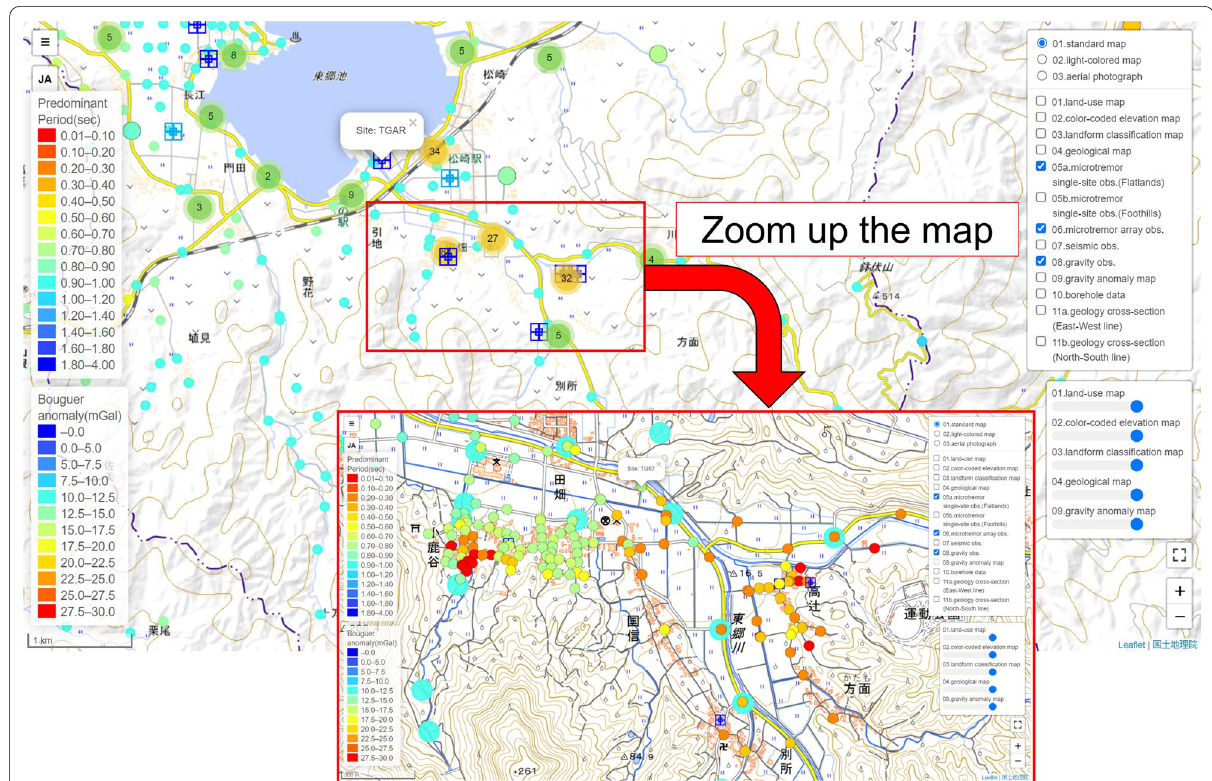
Fig. 3 Examples of a map with symbols of clusters, and a map with symbols of circle colors. The number of clustered points is displayed in the center of the symbol. Color symbols are displayed according to the colors in the legend on the